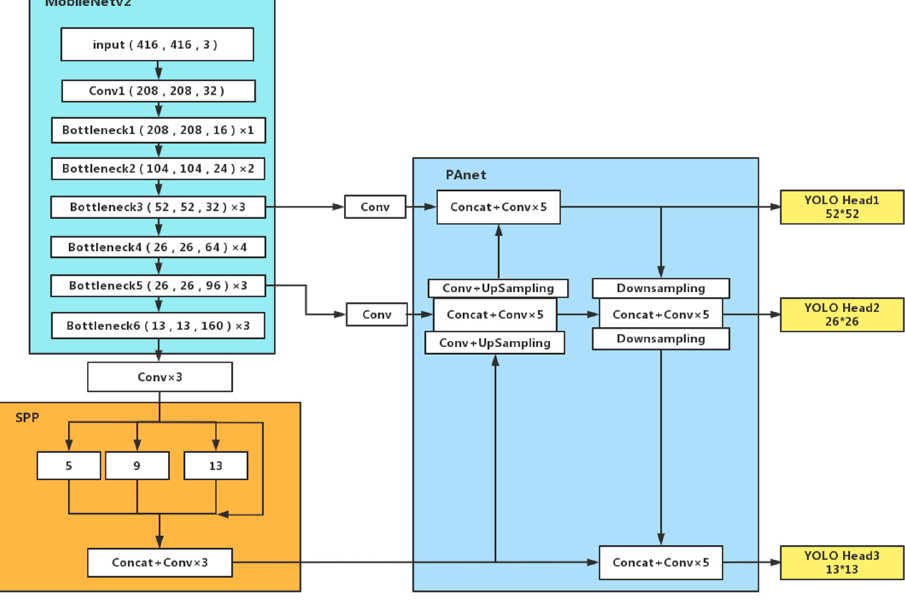
Figure 2. MobileNet-YOLOv4-LITE network structure. Various ships are of different sizes and scales, which are reflected in the SAR images as objects with different pixels. Ship detection becomes a challenging task for SAR images due to its multi-scale feature. Especially for small-scale ships, fewer pixels are easily confused with SAR image speckle noise. Compared with large ships, existing ship detection methods are not sensitive to small ships, resulting in poor accuracy. Thus, the critical issue to improve the detection accuracy of multi-scale ships is how to make full use of the features of different scales to obtain more